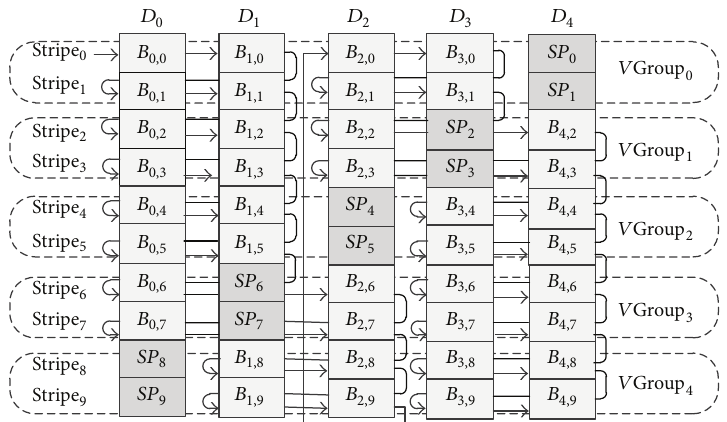
Figure 4: Data layout of S-RAID